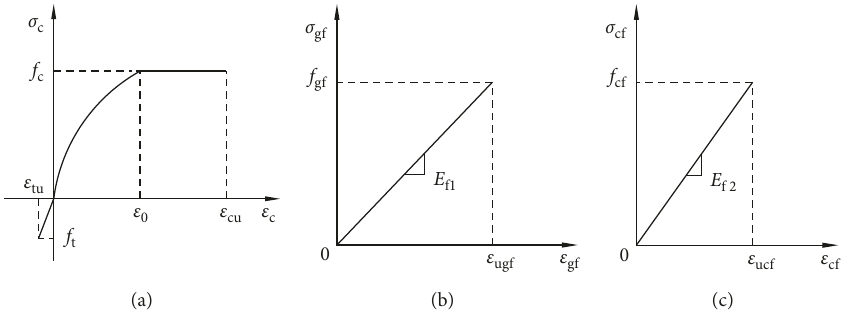
Figure 10: Stress-strain curve of all materials: (a) stress-strain curve of concrete; (b) stress-strain curve of the GFRP plate; (c) stress-strain curve of the CFRP